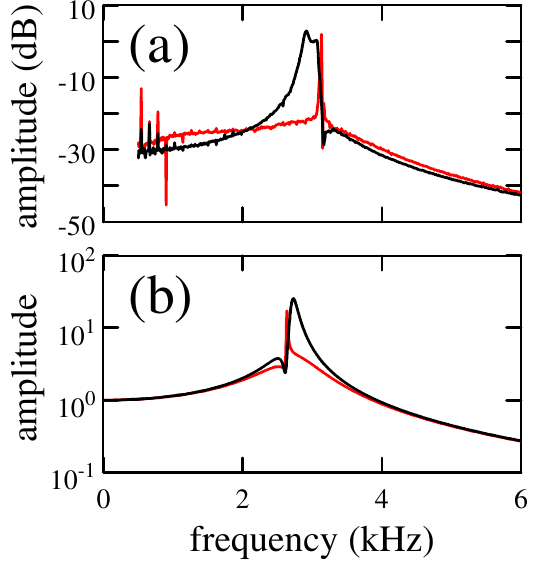
FIG. 6. (Color) Operation with passive harmonic-cavity voltage equaling 74% of that required for optimal bunch lengthening. Black curves: phase feedback off. Red curves: phase feedback on. (a) Experimental measurement of the transfer function phase shift. (b) Phase shift calculated with the beam energy spread equaling its natural value.